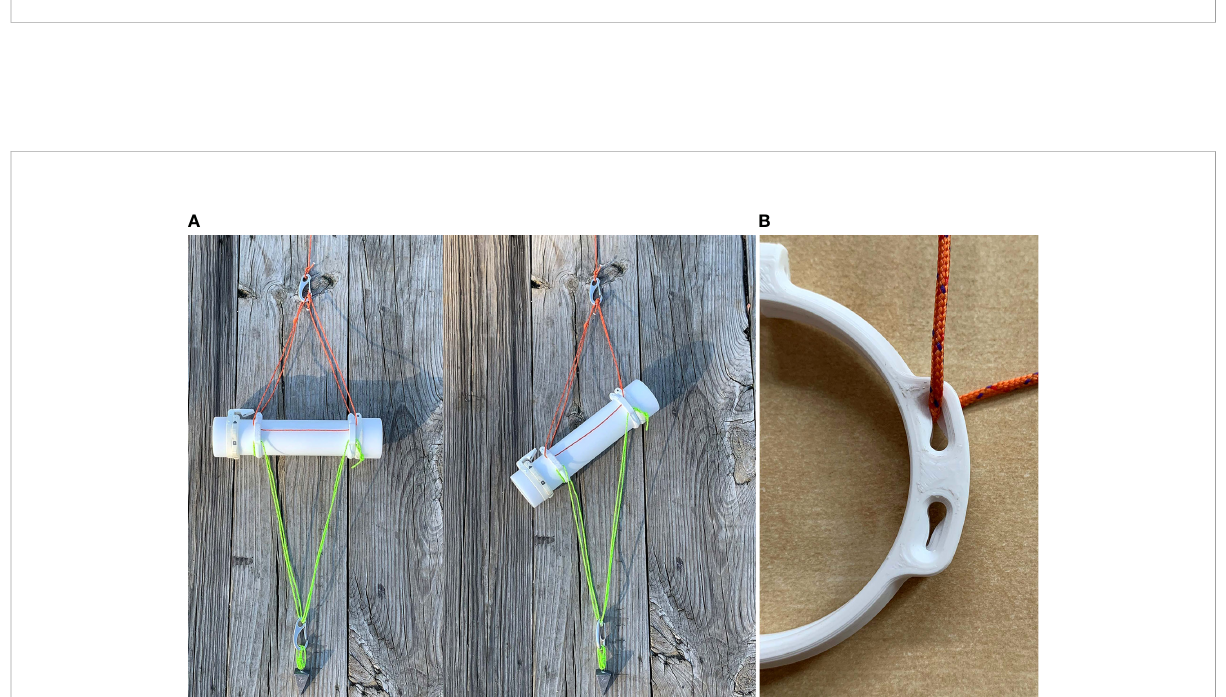
FIGURE 4 (A) The deployment angle of the camera can be adjusted by slipping cords to the desired position. (B) Quick-grip slots lock cords in place when they are under